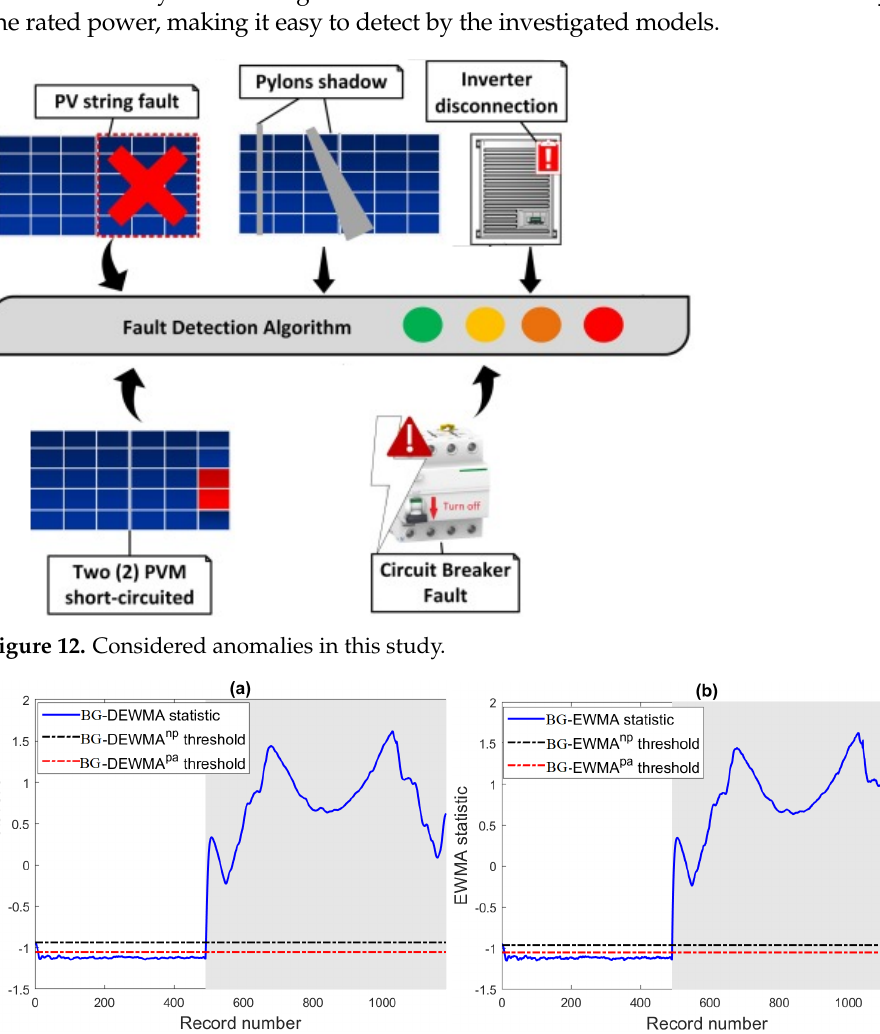
Figure 13. Results of the BG-based schemes in monitoring a string fault: ( a ) BG-DEWMA scheme, and ( b ) BG-DEWMA